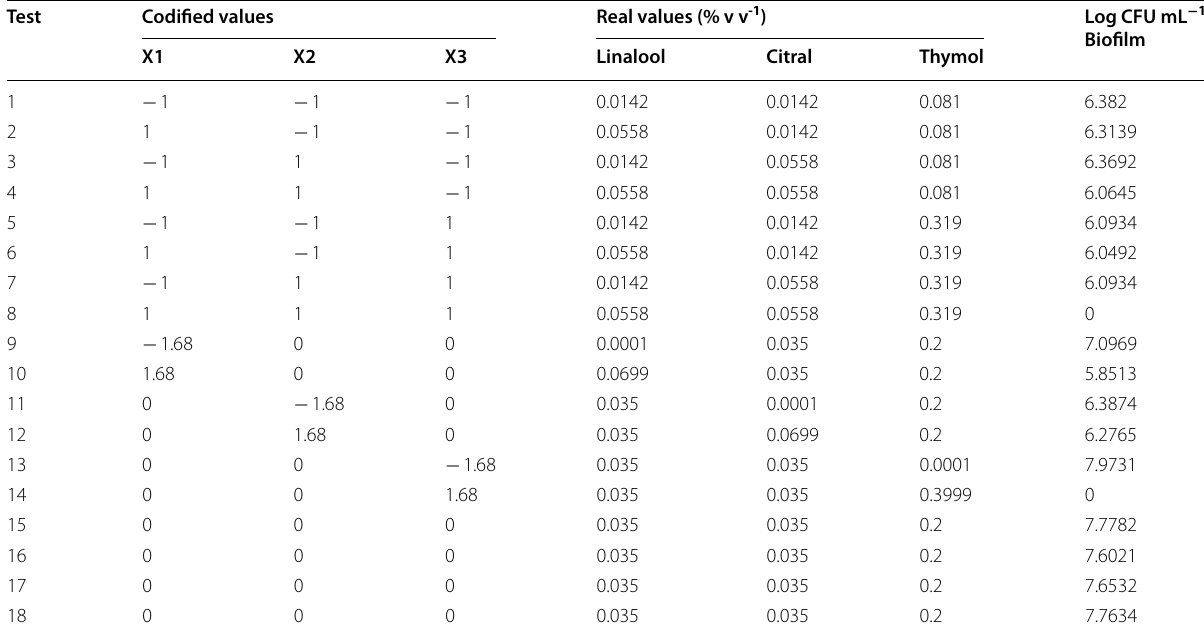
Table 6 Results for biofilm cells count of Shigella flexneri (Log CFU mL − 1 )